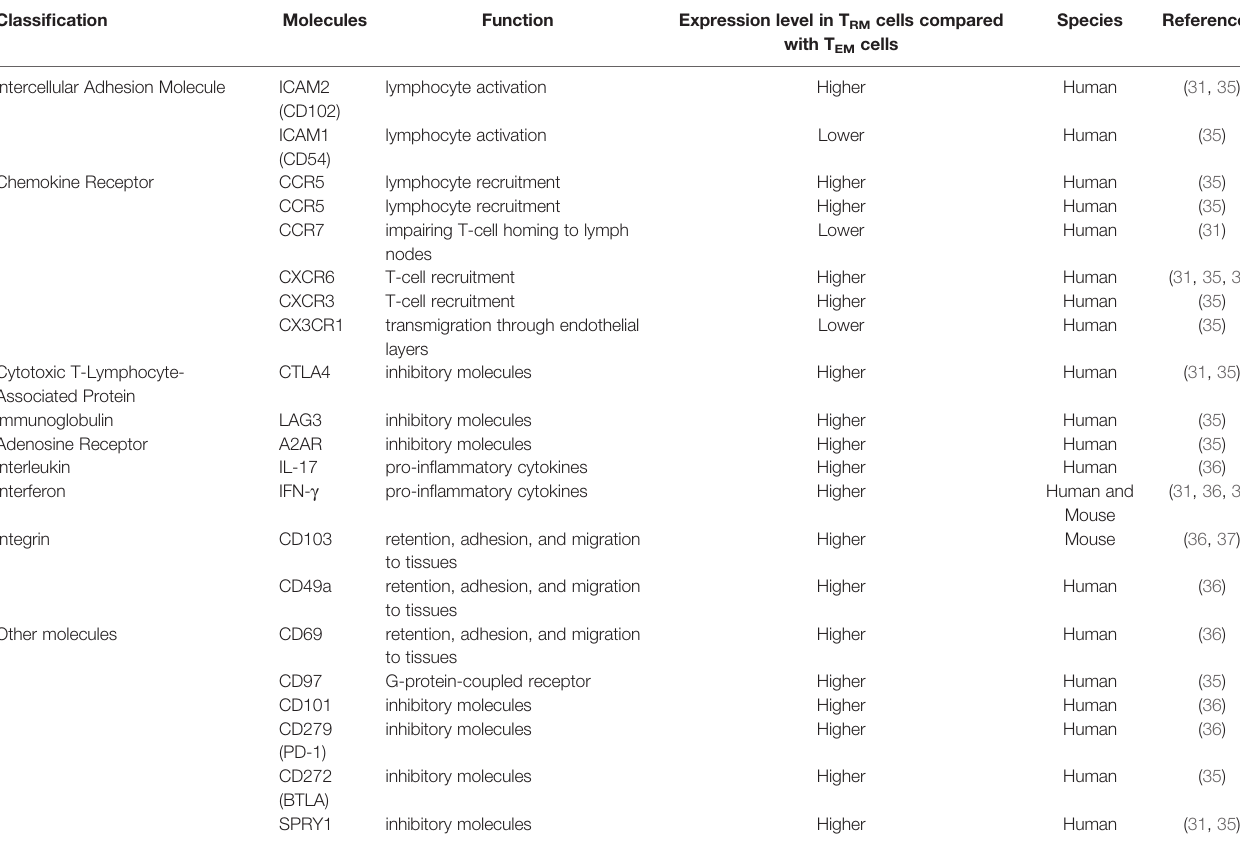
TABLE 1 | The differences in integrins and molecule expression between lung T RM cells and T EM cells. Classi fi